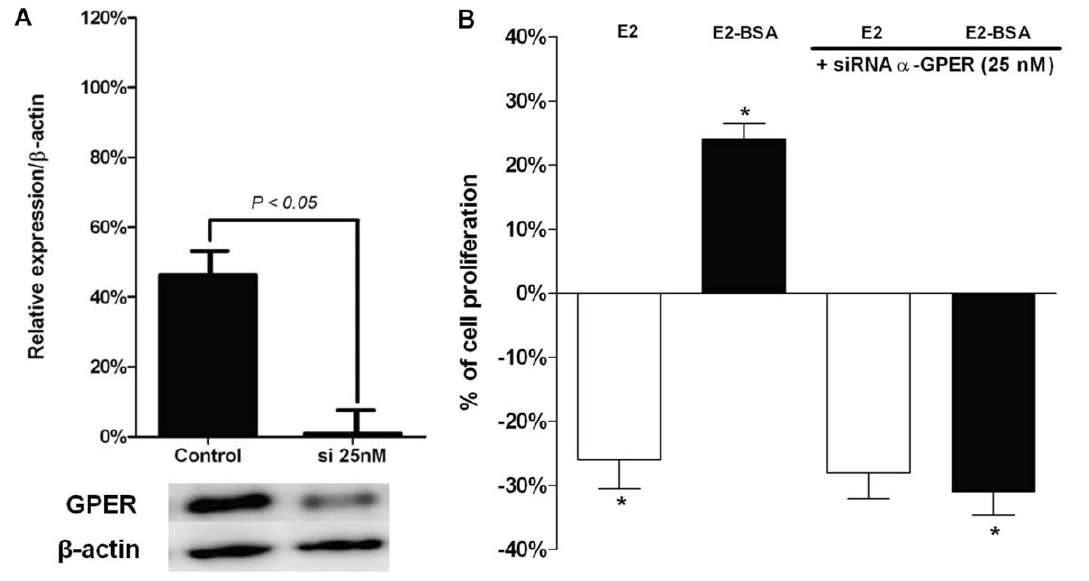
Figure 5. Effects of GPER knockdown on E2 and E2-BSA-induced JKT-1 cell proliferation. (A) JKT-1 cells were transfected with 50 nM of siRNA designed to knockdown GPER or with control siRNA. After 72-h incubation, proteins were extracted and subjected to Western blotting to confirm the specific inhibitory activity of GPER siRNA after normalization with b -actin, which was evaluated as a house-keeping gene. (B) After 72 h transfection with 50 nM of GPER siRNA or control siRNA, JKT-1 cells were incubated for 24 h with E2 (1 nM) or E2-BSA (1 nM). Histograms represent the percentages of variation of the JKT-1 cell number compared to control without estrogens. Cell number was measured at 1,5 6 10 6 cells/well after 24 hours of incubation in the steroid-free medium with ethanol (10% of variation representing an increase or a decrease of 90 000 cells). All results are expressed as means 6 SEM of three independents experiments (*P , 0.01).